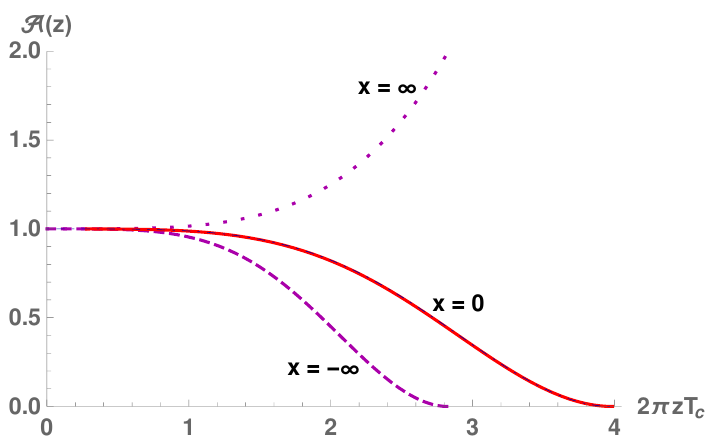
Figure 3 . Evolution of the metric component A ( z ) = z 2 g ττ ( z ) in the Fefferman-Graham co- ordinates with varying x . The dashed and dotted magenta curves show the metric in the cigar (deconfined) and cylinder (confined) limits, respectively. The red curve is the metric in the middle of the domain wall, x = 0 . The dot-dashed thin blue curve is the cigar geometry with z -dependence rescaled by the factor 1 . 41